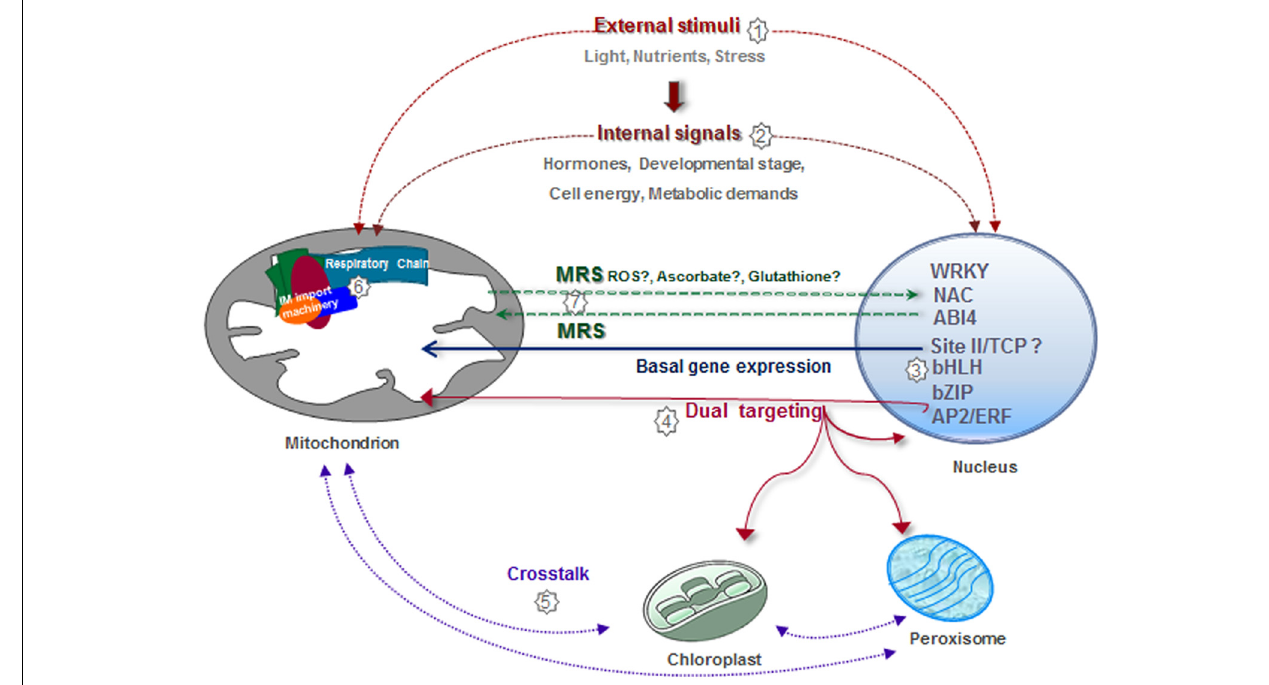
modify the magnitude of the response under different growth conditions. Other transcription factors involved in the expression of nuclear genes encoding mitochondrial components belong to the bZip, AP2/ERF, and bHLH families (3) . Evidence exists demonstrating the presence of proteins dual targeted to different organelles, which may act to coordinate the activities of these organelles (4,5) . Physical and functional interactions between the inner membrane (IM) import machinery and complexes I, III, and IV help to adjust gene expression and protein assembly (6) . Mitochondria generate signals to modify nuclear gene expression according to organelle demands (7)